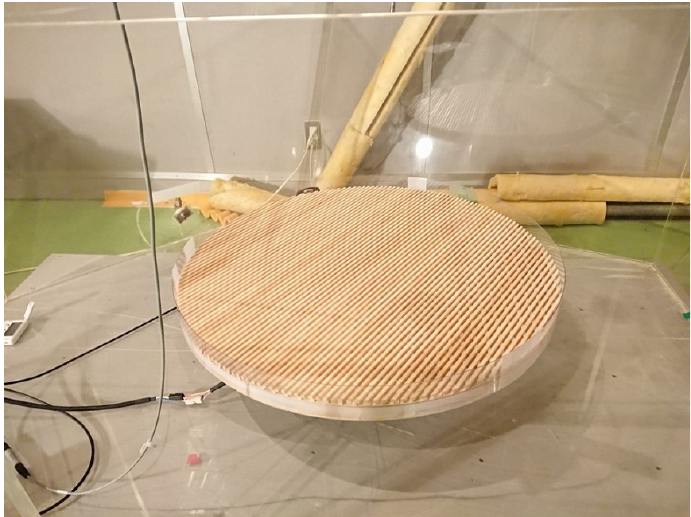
Figure 3. 1/5 scale sample of CRD surrounded with a plastic border for scattering coeffi- cient measurement.